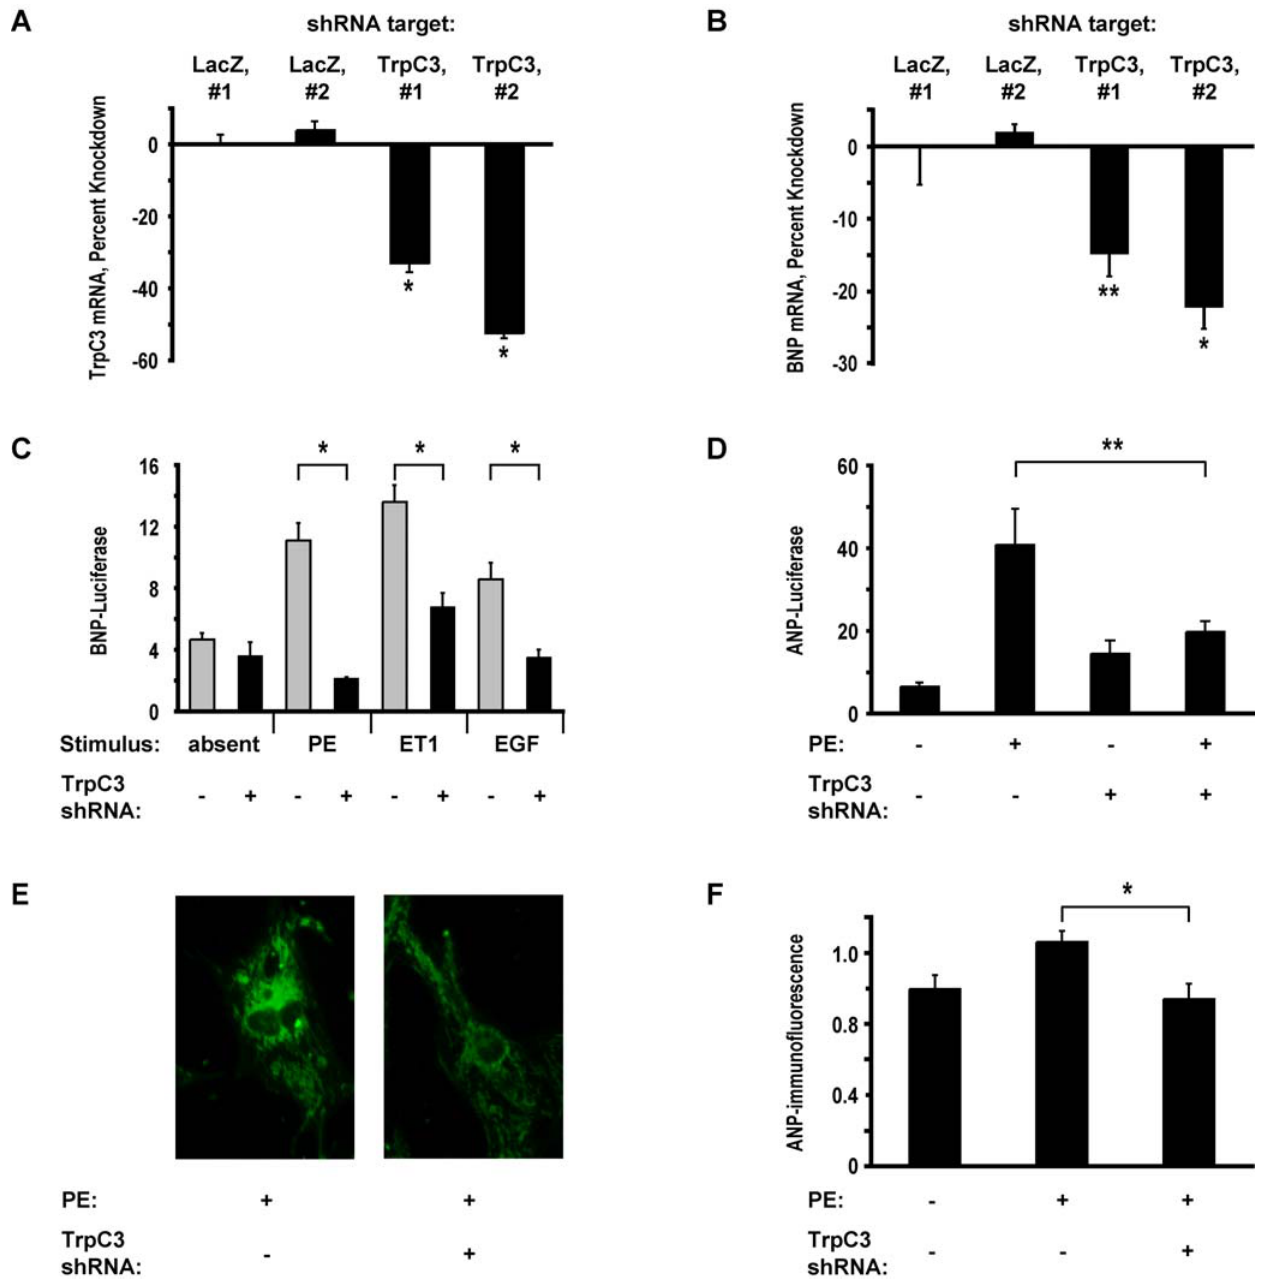
Figure 2. TrpC3 is necessary for hypertrophic gene expression. ( A ) Real-time RT-PCR measurement of TrpC3 mRNA in myocytes infected with lentiviruses expressing shRNAs targeting either LacZ or TrpC3. Data is presented as percent decrease in expression compared to the mean expression of myocytes expressing LacZ-shRNA # 1. Asterisks indicate significant difference compared to LacZ-shRNA # 1. n=4 per condition. ( B ) Real time RT-PCR measurements of BNP mRNA levels in myocytes infected with the same lentiviruses as in A . TrpC3 shRNAs reduce the expression of endogenous BNP mRNA. n=4 per condition. ( C ) Luciferase activity in myocytes transfected with BNP-Luc and plasmids expressing shRNAs targeting either TrpC3 or LacZ. Cells were stimulated for 60 hours with 20 m M phenylephrine (PE), 100 nM endothelin-1 (ET1) or 150 ng/mL epidermal growth factor (EGF) to induce hypertrophy. n=4 biological replicates per condition. ( D ) Luciferase expression in myocytes transfected with ANP-Luc and untreated or stimulated with 20 m M PE. n=6 biological replicates per condition. ( E ) Myocytes transfected with plasmids expressing shRNAs targeting either LacZ or TrpC3 were stimulated with 20 m M PE for 60 hours and then fixed and immunostained with an anti-ANP antibody. TrpC3 shRNA expression caused a decrease in ANP staining. (F) Quantification of immunostained cells treated as in E . The integrated ANP-immunofluorescence intensity across the two-dimensional projection of transfected cells was measured. Average n=31 cells per condition. In all panels, cells not expressing TrpC3-shRNA were expressing a control shRNA against LacZ. * indicates statistically significant difference compared to control, P , 0.01. ** indicates P , 0.05. For all bar graphs, data are represented as mean 6 SEM.